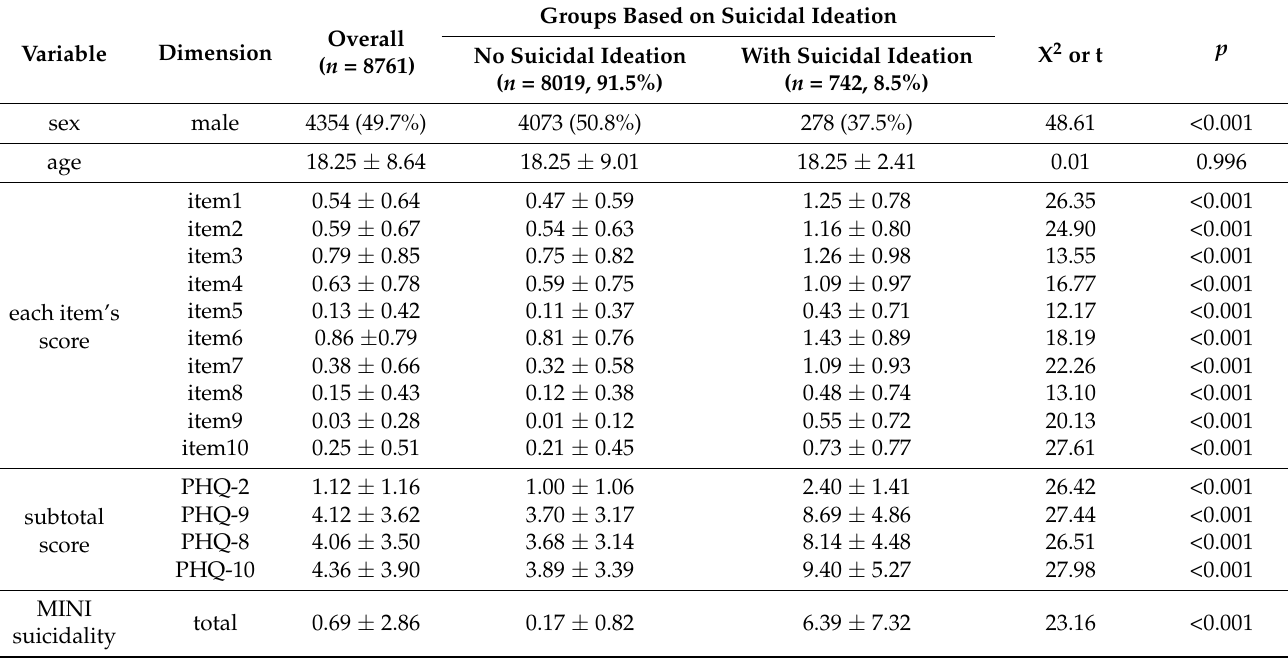
Table 1. Differences in response and general characteristics of each group according to suicidal ideation.